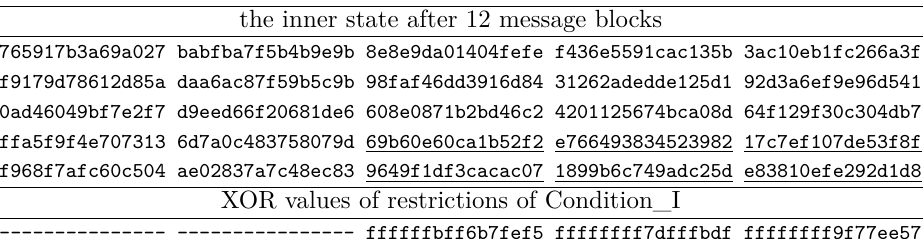
Table 8: The inner state H (in little-endian